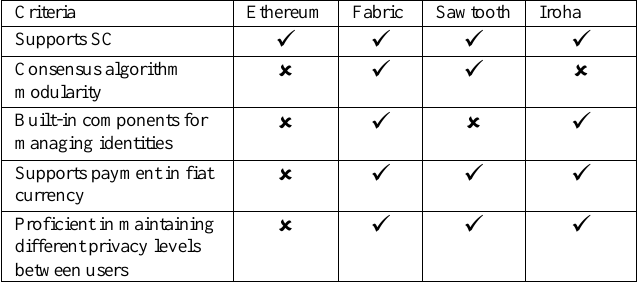
Table 1: Trade-off analysis between Ethereum, Fabric, Sawtooth, and Iroha.